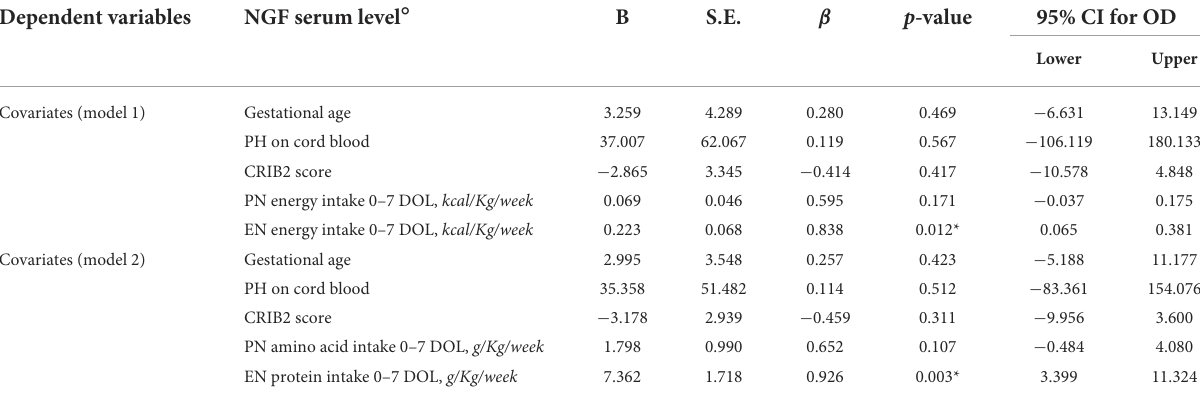
TABLE 2 Multivariate analysis of covariates influencing NGF serum level at 28 days of life in preterm newborns. Dependent